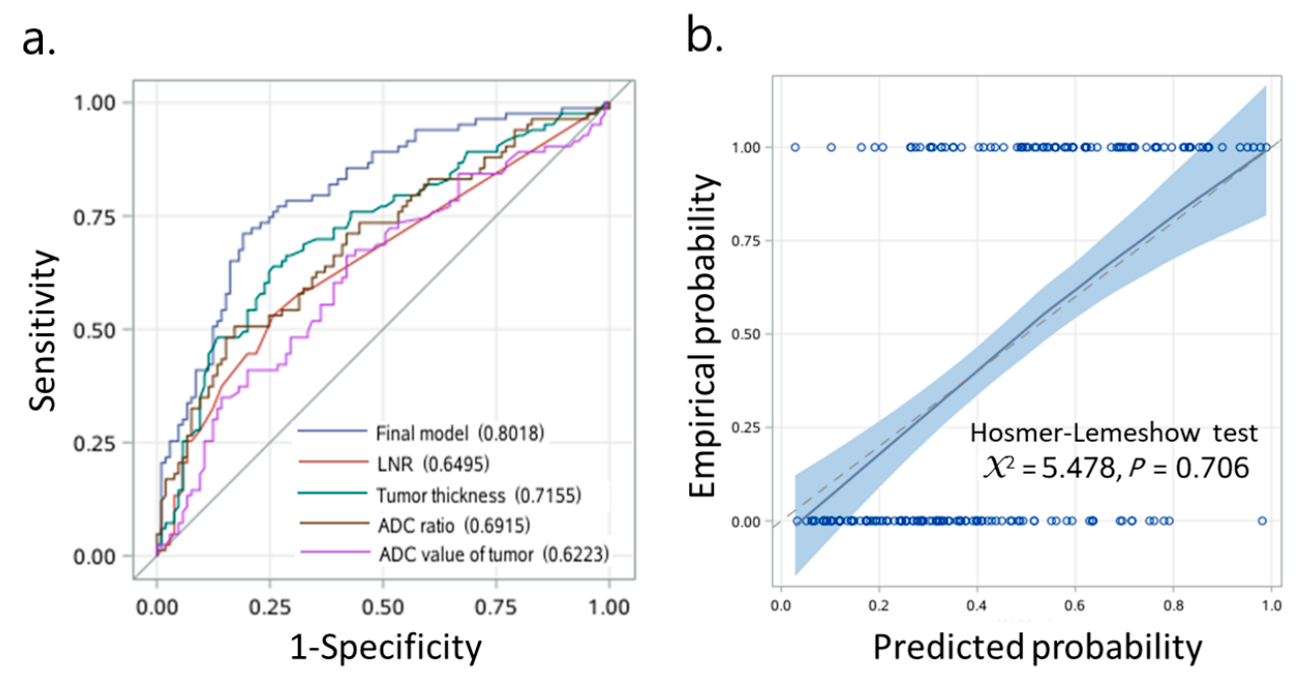
Figure 3. Time-dependent receiver operating characteristic (ROC) curve for disease free survival. AUC, area under the curve.